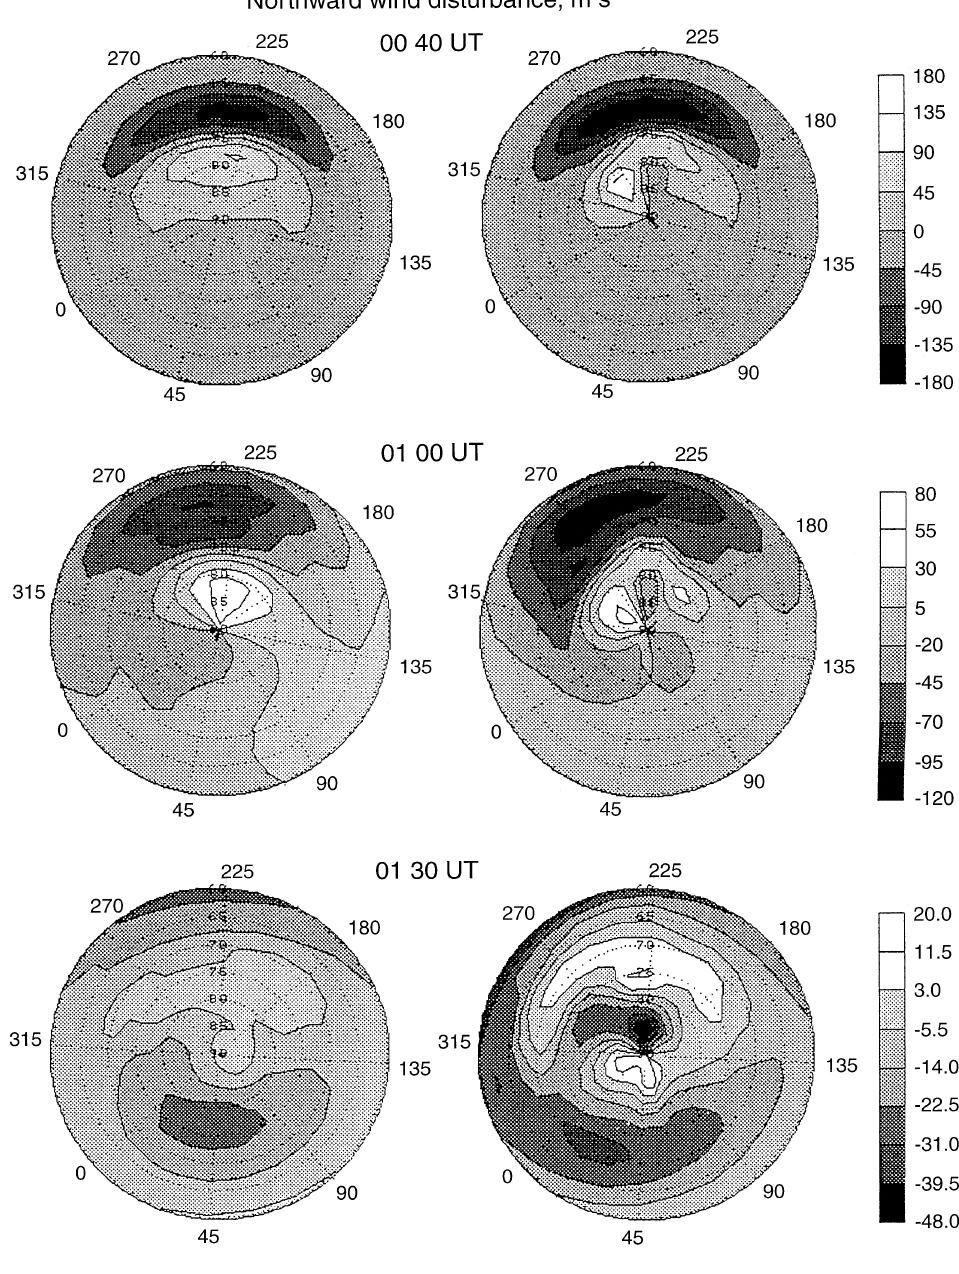
Fig. 9. The same as in Fig. 8 but for the meridional (posit- ive northward) thermospheric- wind-velocity disturbance at h " 300